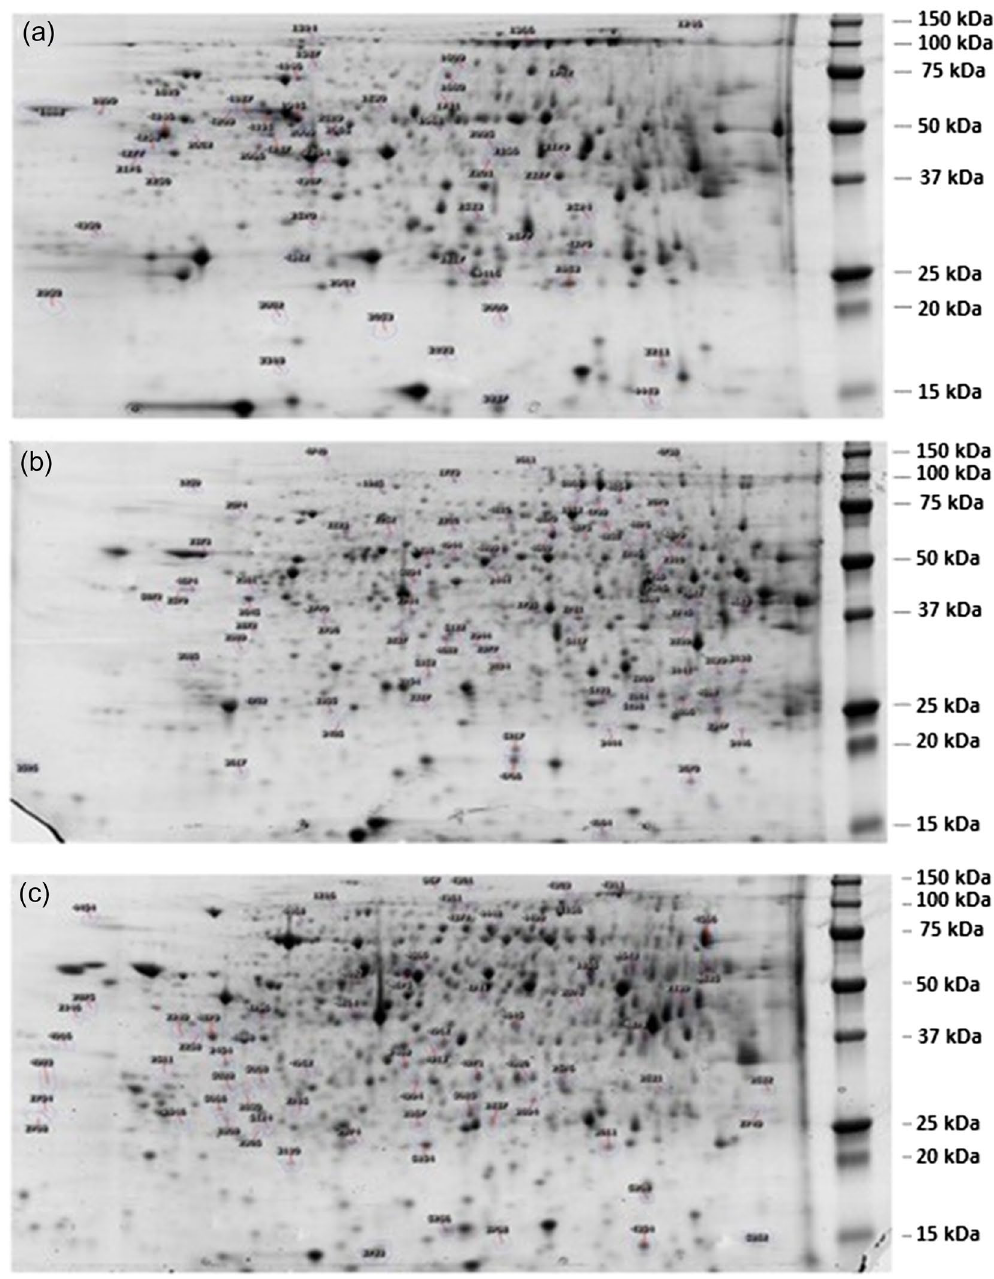
Figure 1. A representative two-dimensional gel of liver proteins of ( a ) gilthead seabream ( Sparus aurata ), ( b ) European seabass ( Dicentrarchus labrax ) and ( c ) rainbow trout ( Oncorhynchus mykiss ) fed 0% inclusion of T. molitor (TM) meal. Protein spots showing significant changes in their abundance are indicated by a